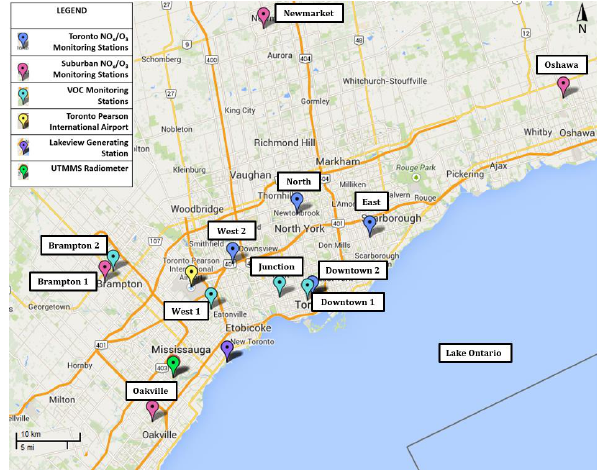
Figure 1. Monitoring stations in the Greater Toronto Area used for the collection of NO x and O 3 data (blue and pink markers), VOC data (aqua markers) and meteorological data (yellow and green